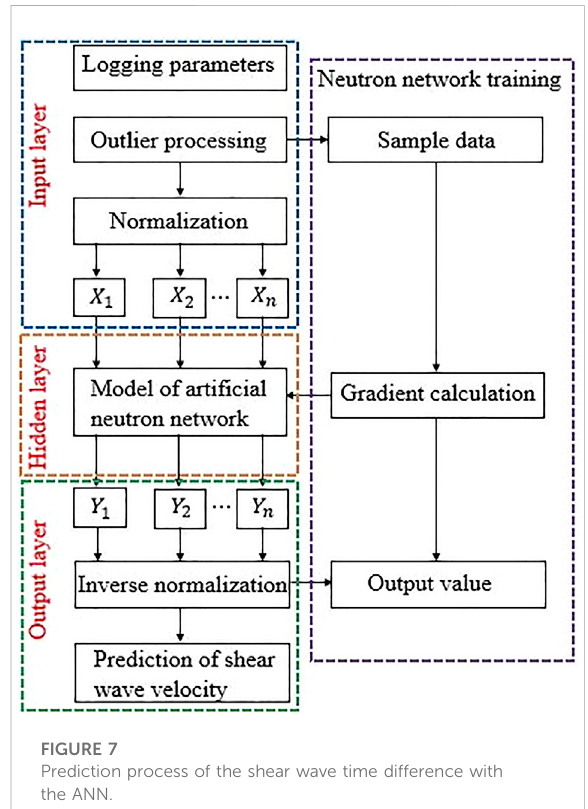
FIGURE 7 Prediction process of the shear wave time difference with the